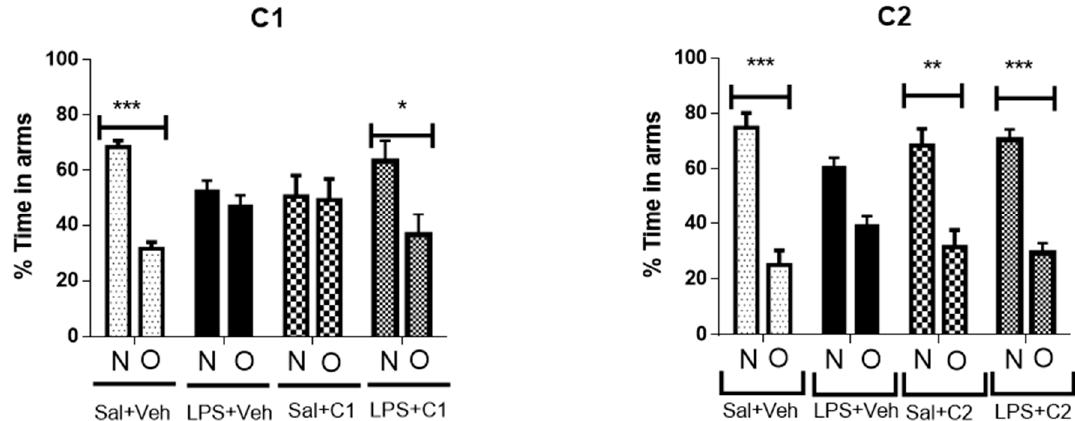
Figure 15. Effects of treatment in time spent in novel (N) and old (O) arms. Saline (sal), Vehicle (veh, vehicle used for the ligand dilution). ** p < 0.05, ** p < 0.01, *** p < 0.001 of novel area against old area.